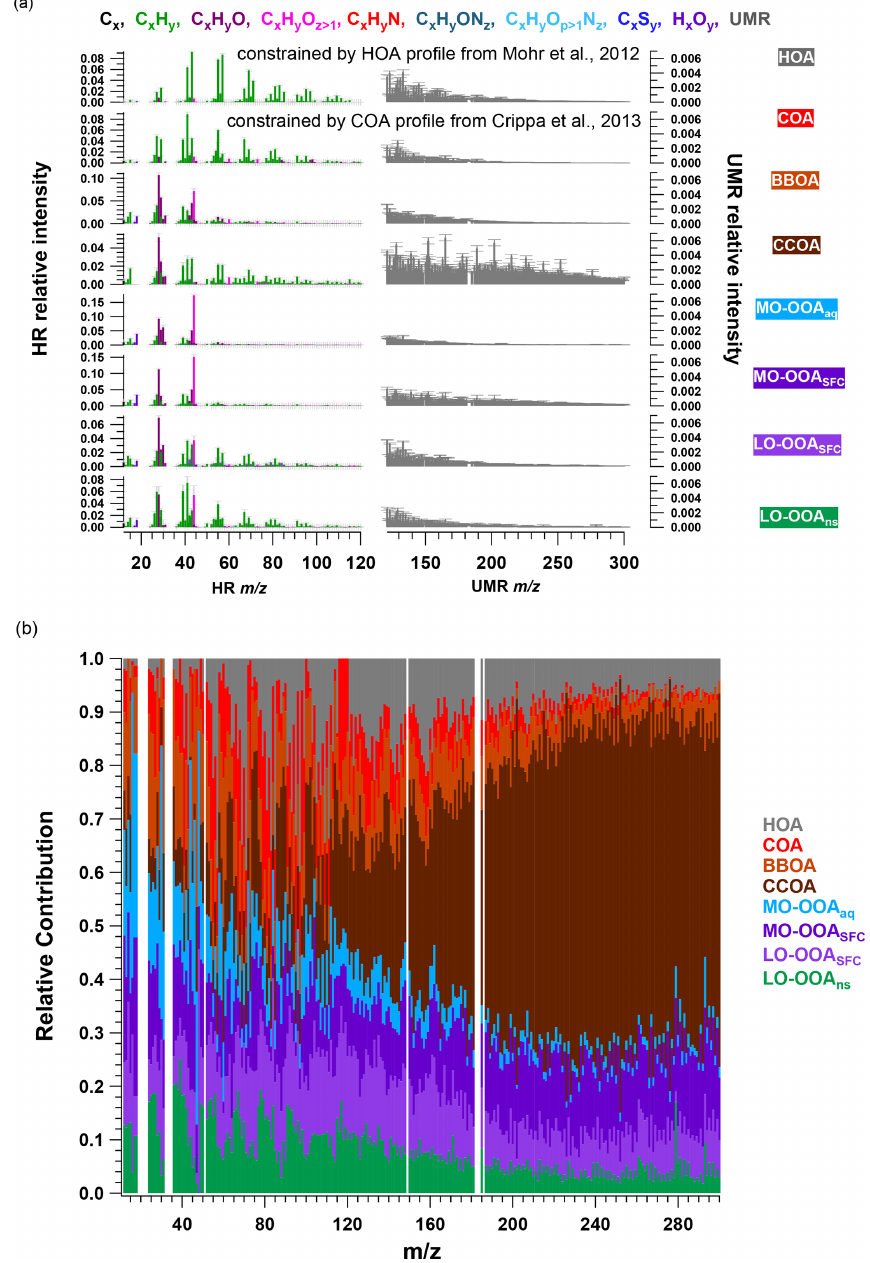
Figure 2. Averaged mass spectra (a) and relative contributions (b) of the eight-factor solution from the AMS PMF bootstrap result. The mass spectra consist of HR ions from m/z 12 to 120 and integrated integer m/z (denoted UMR) from m/z 121 to 300, whose intensity is multiplied by 5. In (a) , error bars denote standard deviation calculated from all accepted bootstrap